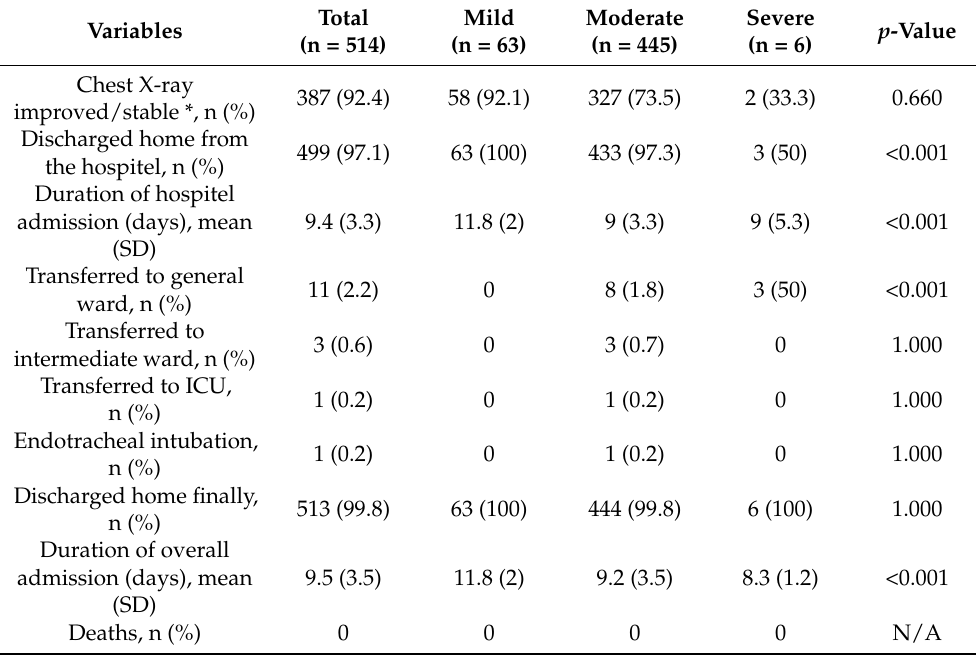
Table 2. Clinical outcomes of 514